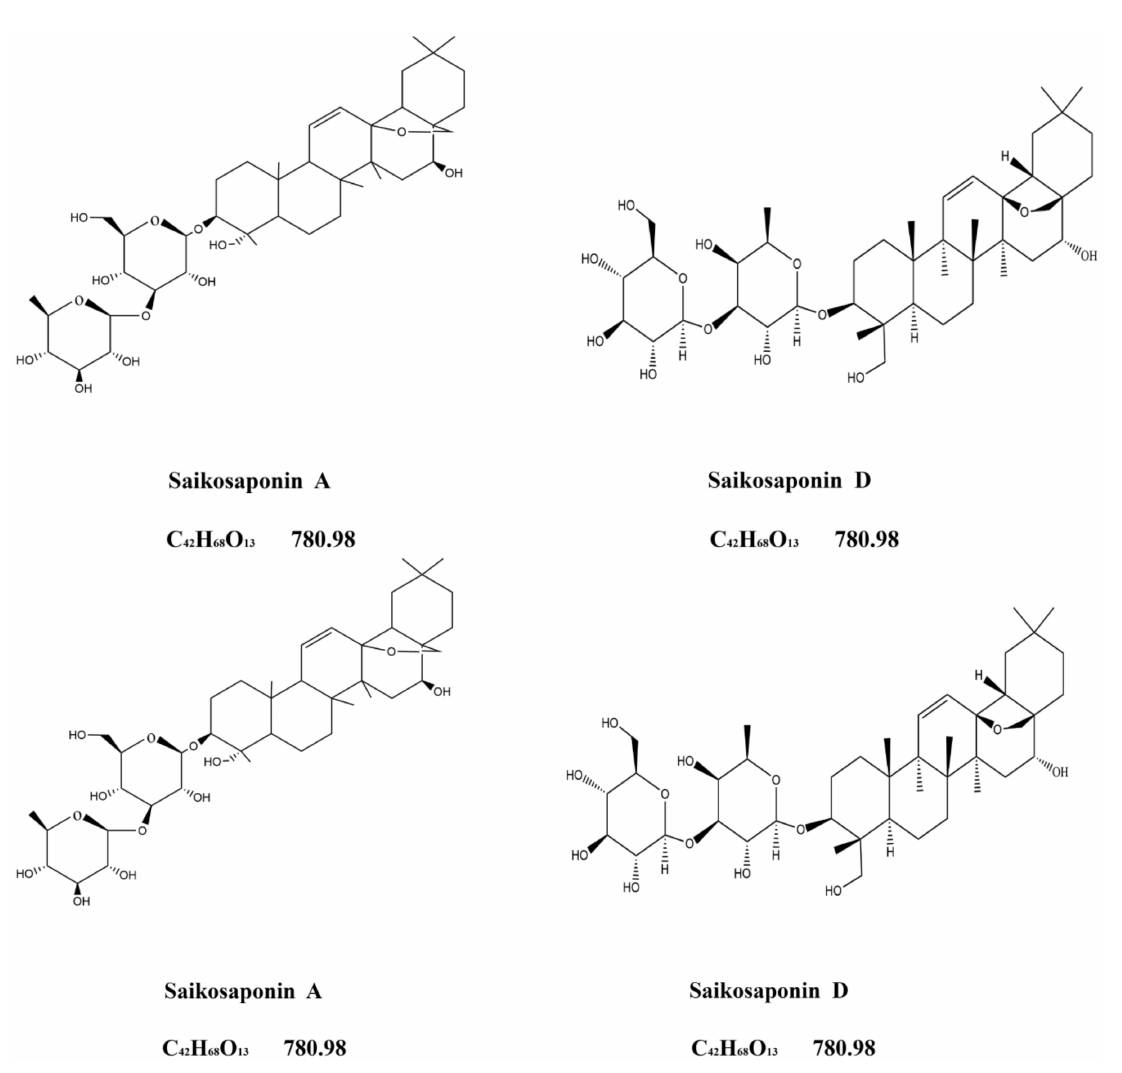
Figure 8. Molecular formula and molecular weight of saikosaponin A and D. Table 2. Elution